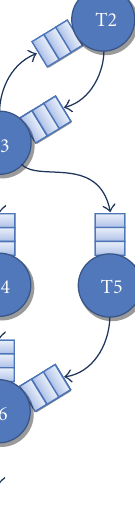
Figure 13: Example of task